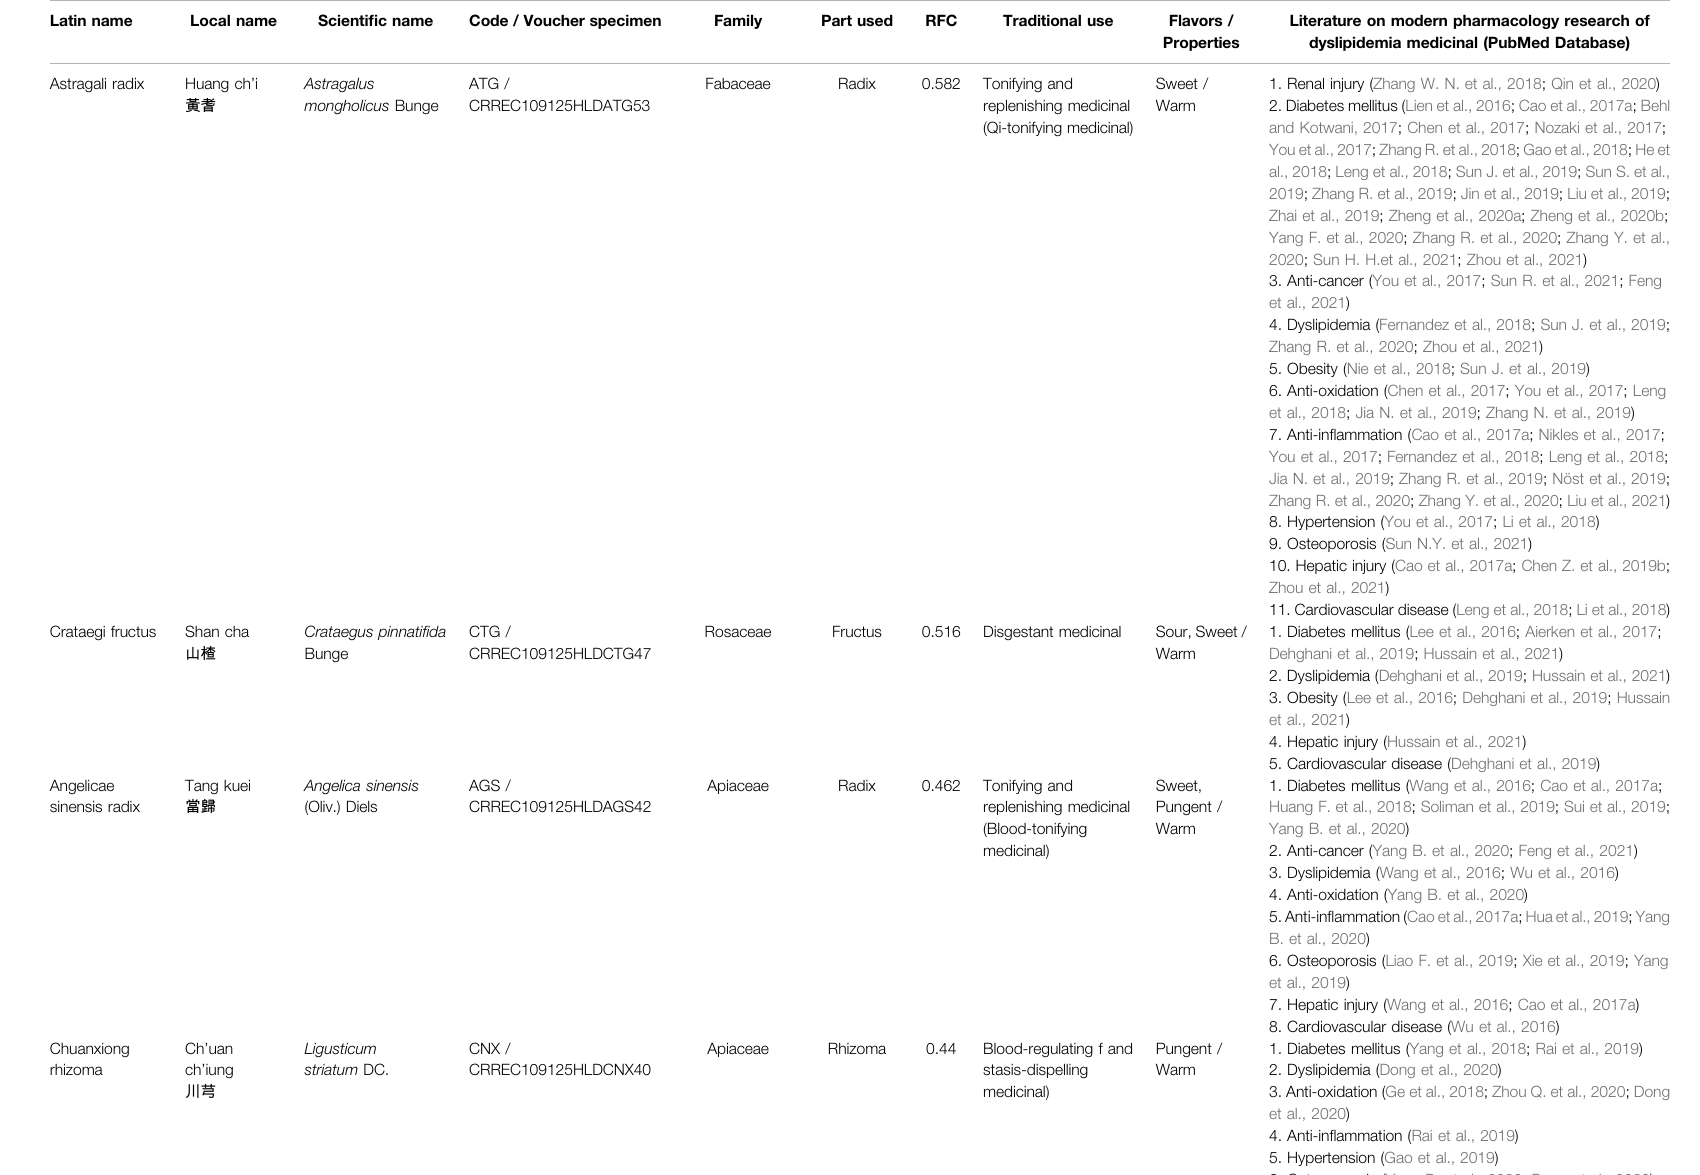
TABLE 1 | Commonly used medicinal materials with RFC >